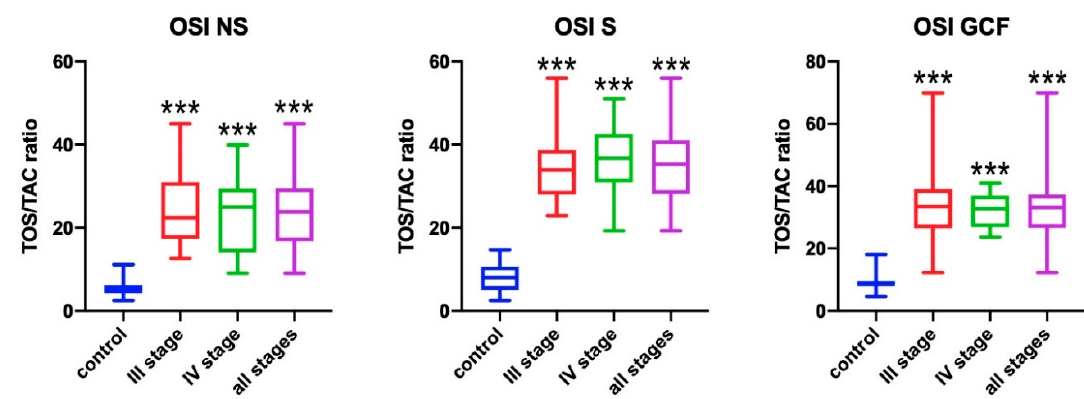
Figure 3. Concentrations of oxidative stress index (OSI) in non-stimulated saliva (NS), stimulated saliva (S), and gingival crevicular fluid (GCF) in all patient groups. *** p < 0.001 vs. control group.